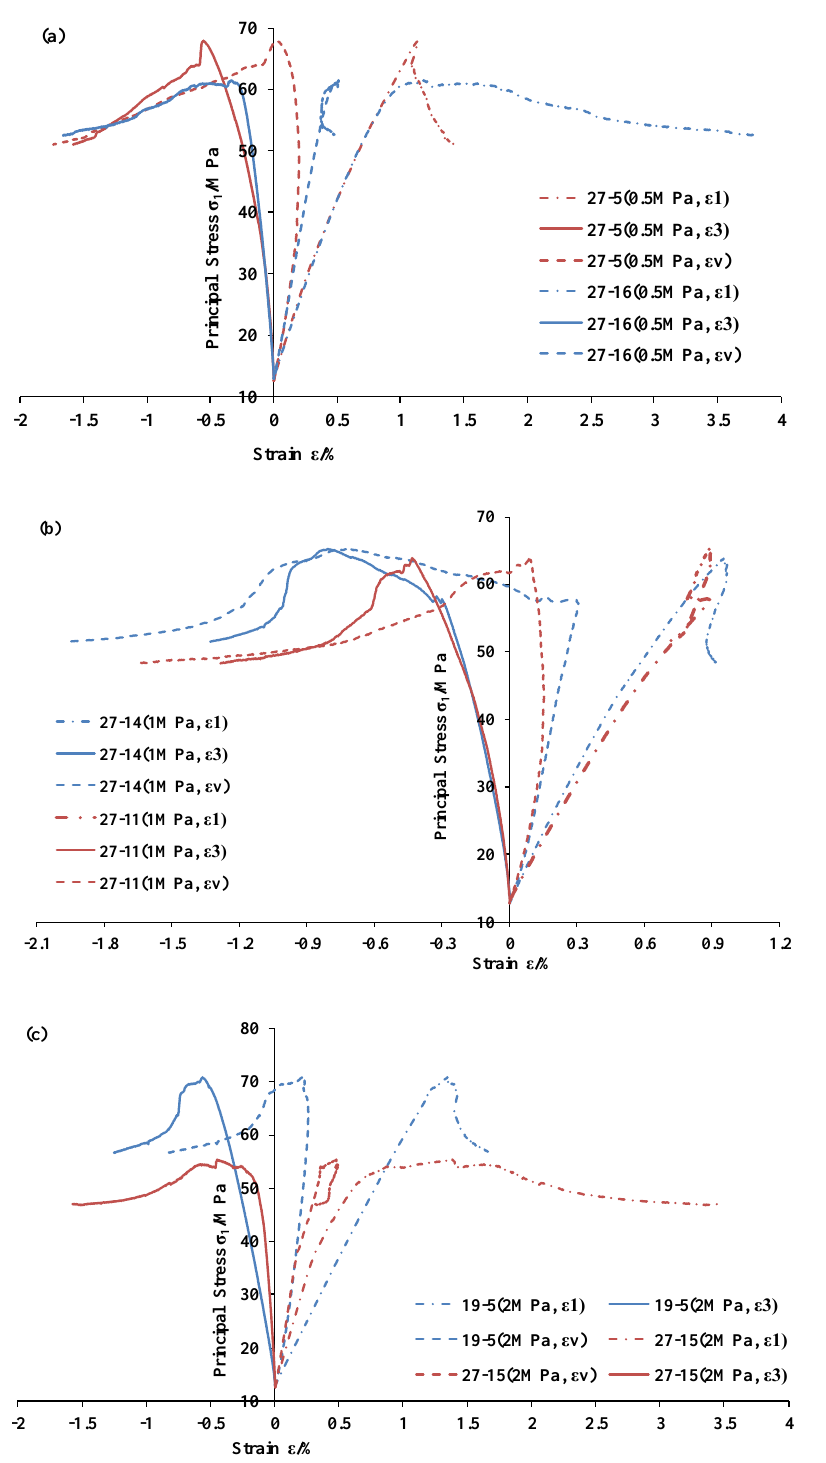
Figure 6. Complete stress-strain curves of CTC coal samples with di ff erent gas pressures: ( a ) 0.5 MPa; ( b ) 1 MPa; ( c ) 2